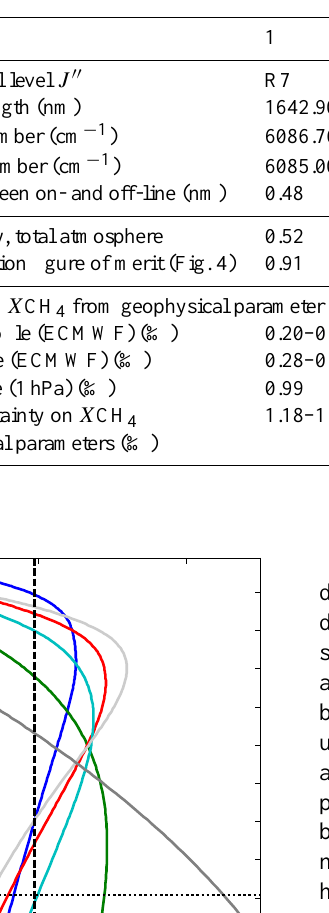
Table 1. Suitable line multiplets in the 2 ν 3 methane absorption band for space IPDA lidar applications, with proposed online/offline lidar wavelength pairs and uncertainties due to atmospheric temperature, humidity, and surface pressure uncertainties (for details see Appendix). Option 2 at 1645nm is selected due to its outstanding sensitivity in the lower troposphere.